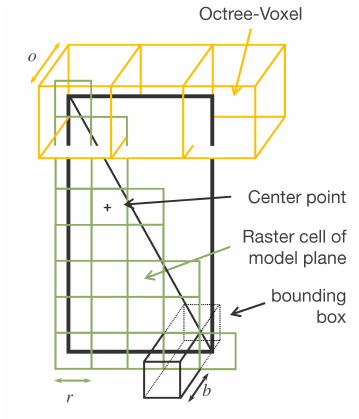
Figure 1. Main components for the as-built as-planned compar- ison. The black rectangle represents a surface of a building ele- ment split into two triangles. The orange octree cells are used for visibility checks. The green raster cells split each triangle into smaller elements. For each raster cell a measure is calculated based on the points extracted by the bounding